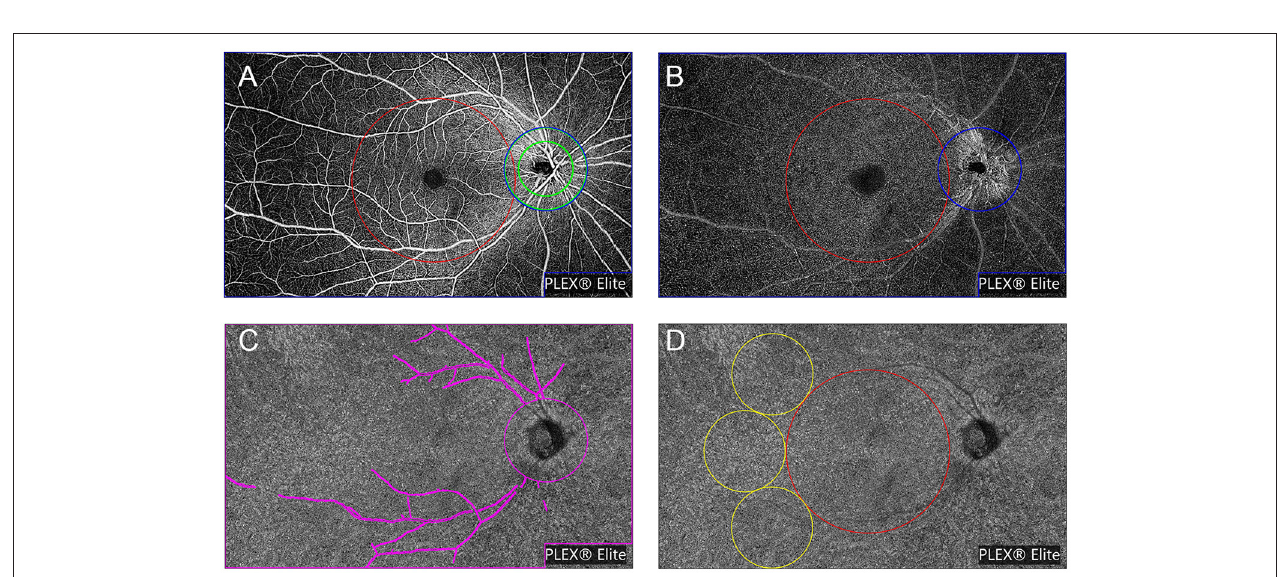
FIGURE 1 | Demonstration of representative images of different slabs in three groups. (A,D,G) Slabs are from a healthy volunteer (No. 14, the right eye). (B,E,H) Slabs are from a patient with acute VKH disease (No. 12, the left eye). (C,F,I) Slabs are from a patient with quiescent VKH disease (No. 17, the right eye).